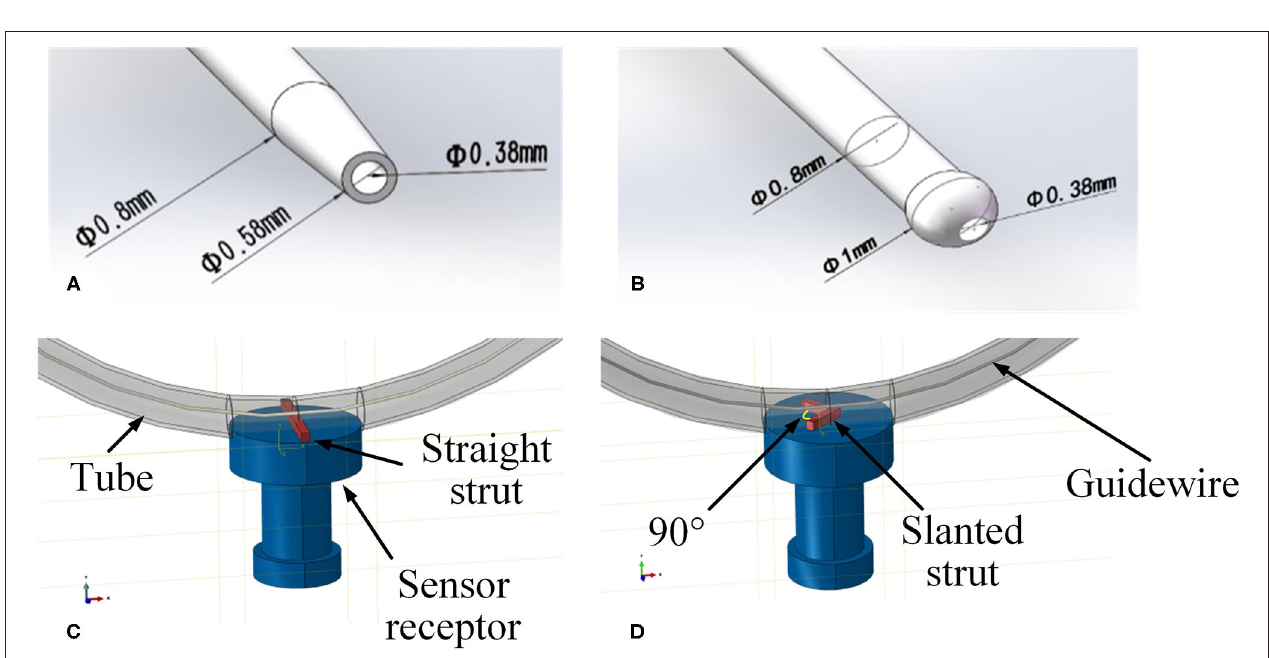
FIGURE 3 | Geometries of experimental FE model. (A) Tip of the traditional catheter, (B) tip of the spherical-tip catheter, (C) straight strut model, and (D) slanted strut for finite element model.